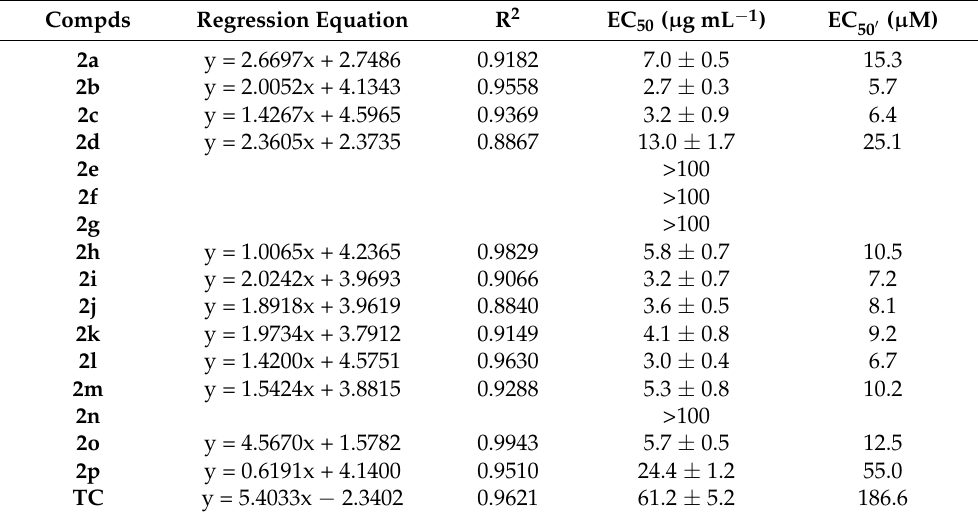
Table 2. EC 50 of highly bioactive compounds against Xoo .